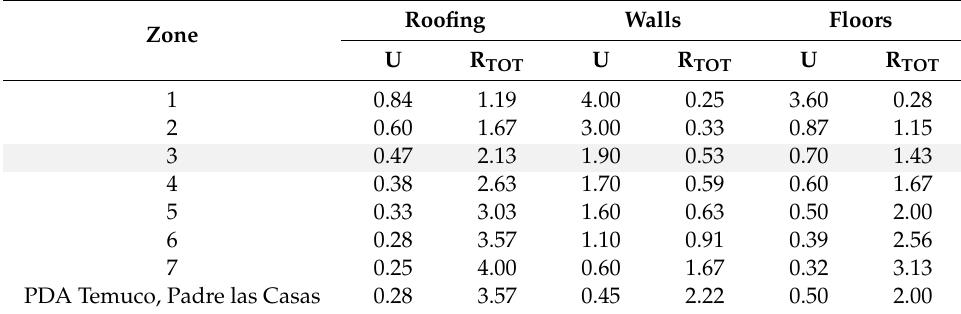
Figure 3. Detailed perimeter wall, plan view. Own elaboration. Table 1. Requirements of transmittance and thermal resistance for elements of the envelope according to Article 4.1.10 General Urban Planning and Construction Ordinance and according to the Atmospheric Decontamination Plan for the communes of Temuco and Padre Las Casas in Chile.